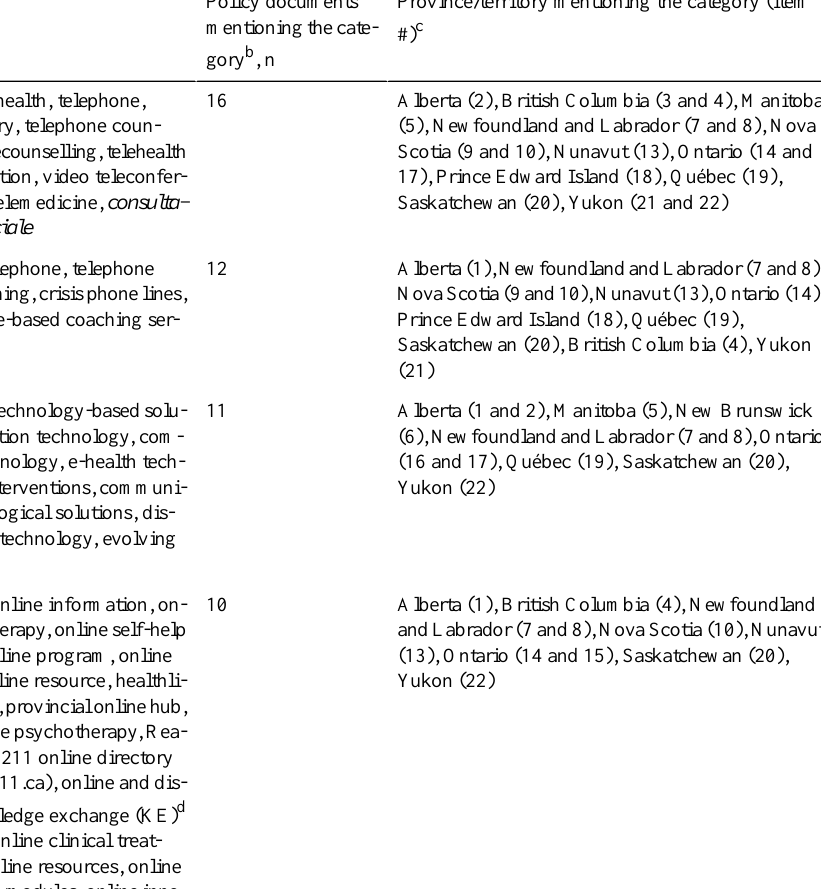
Province/territory mentioning the category